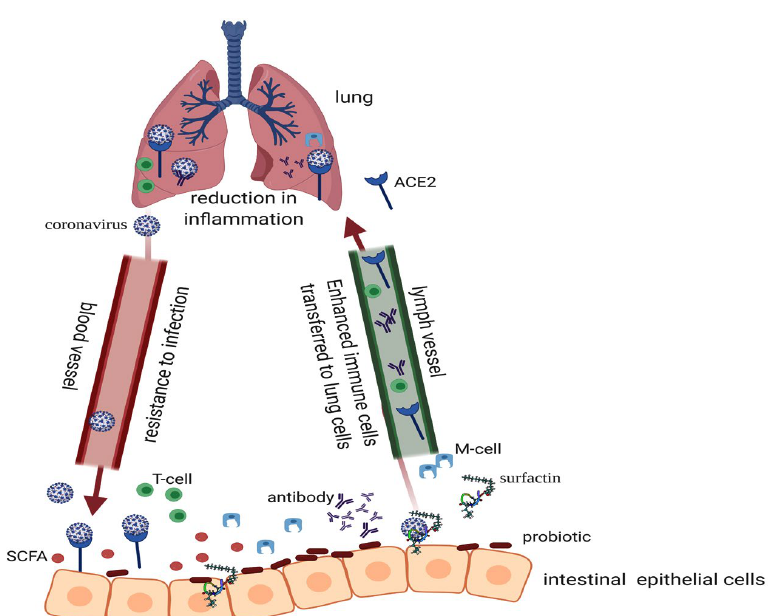
Fig. 1. The beneficial metabolites of probiotics and the enhancing antiviral immunity to provide protection to the